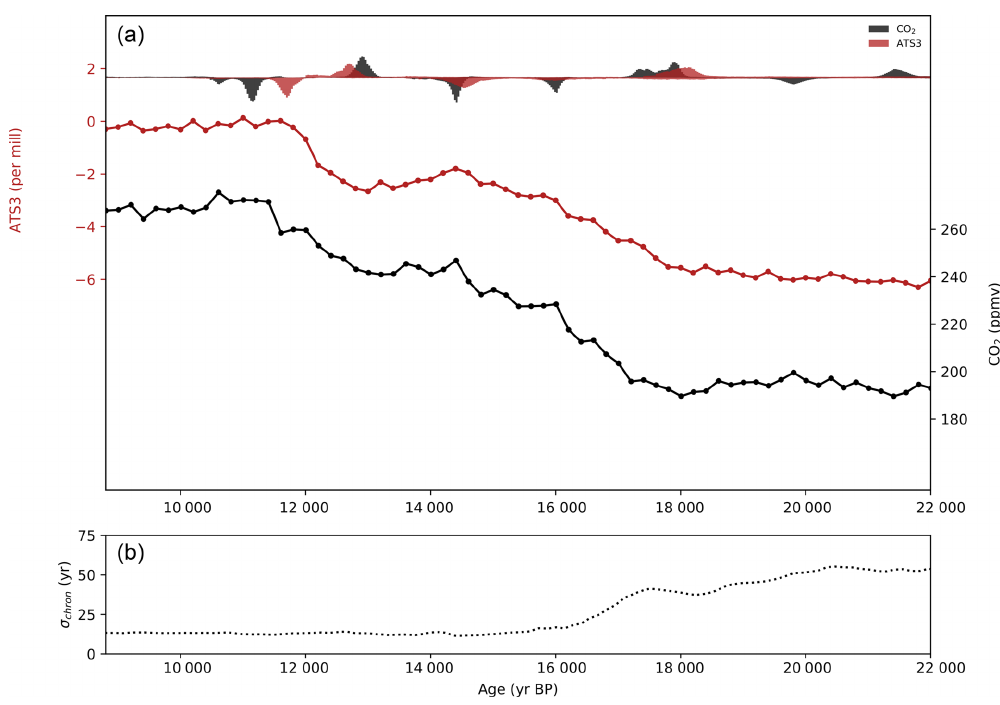
Figure 4. (a) Savitzky–Golay filtered atmospheric CO 2 (black) and ATS3 (red) placed on a common timescale with the normalized his- tograms of probable change points (eight-point simulations, allowed to fit six points per series). Histograms are plotted downward-oriented when the rate of change decreases and upward-oriented when it increases (same colors, y axis not shown, probabilities range from 0 (center) to 0.0024 (top and bottom)). (b) Chronological uncertainty, taken as the sum of the (cid:49) age uncertainties and the uncertainty estimate for our volcanic